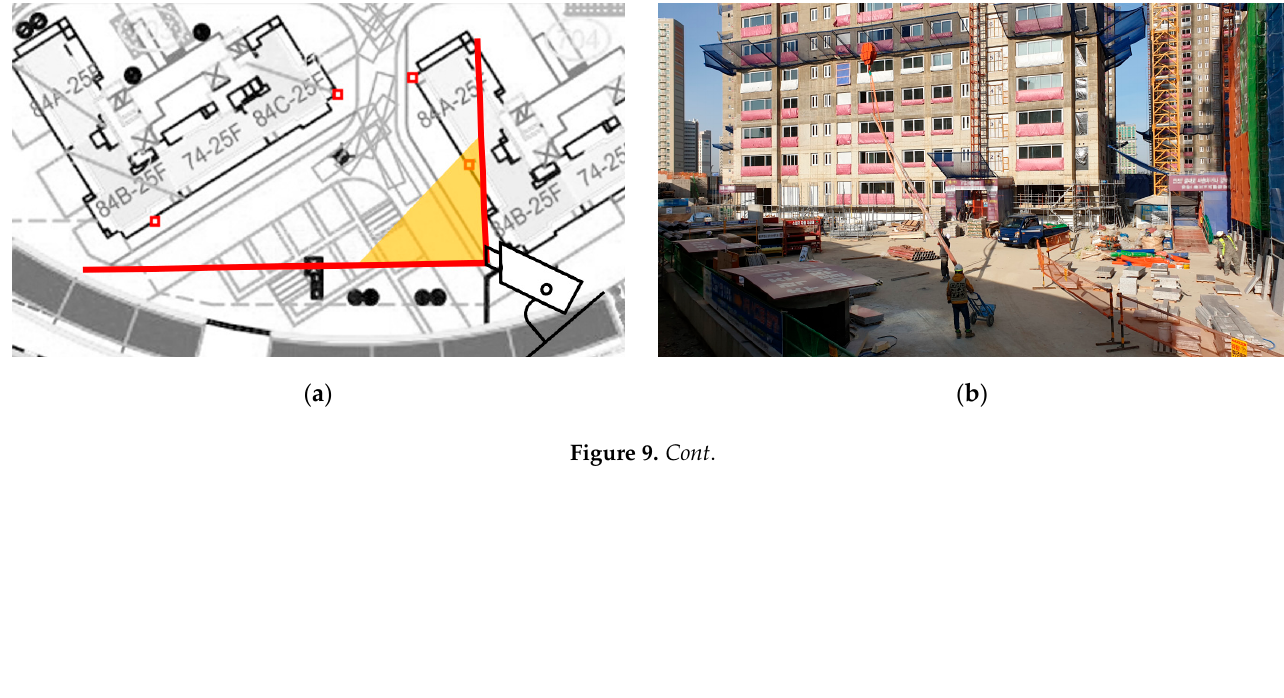
Figure 8. Inputting of XY coordinates of reference drawing.